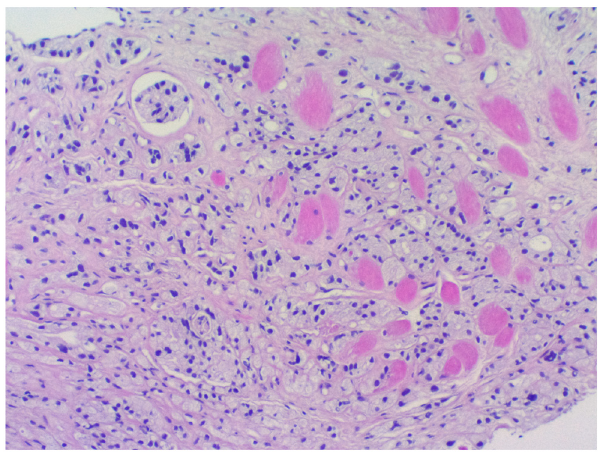
Figure 7. Invasive prostatic adenocarcinoma infiltrating into skeletal muscle (H&E stain, X200